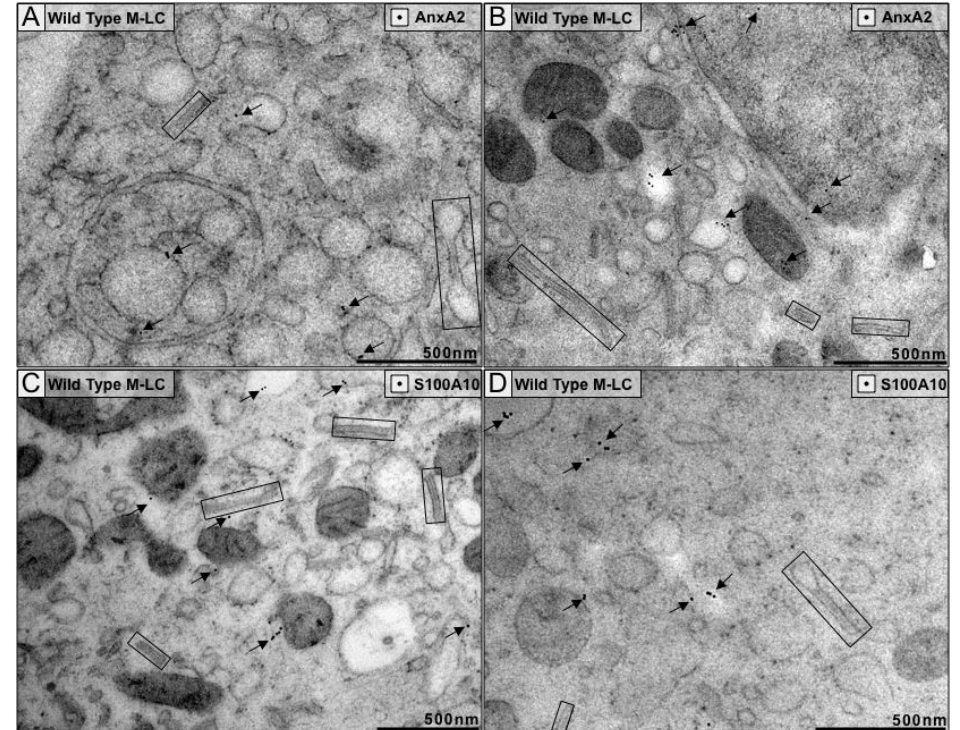
Figure 2. Neither subunit of the annexinA2 S100A10 heterotetramer (A2t) localize to BG in wild type M-LC. Immunoelectron microscopy with 10 nm gold particles was used to visualize the cellular distribution of anxA2 ( A , B ) and S100A10 ( C , D ). BG are boxed and gold labels are indicated by arrows. Images represent staining from tree independent biological replicates and a minimum of 3 grids.